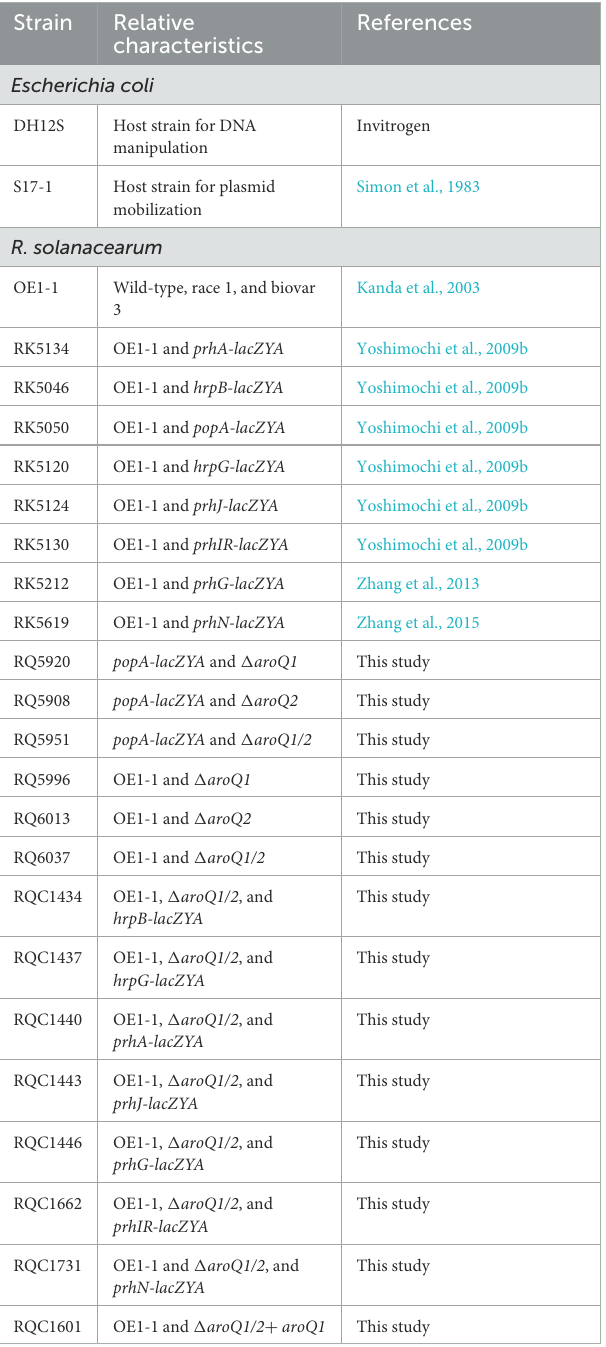
TABLE 1 Bacterial strains used in this